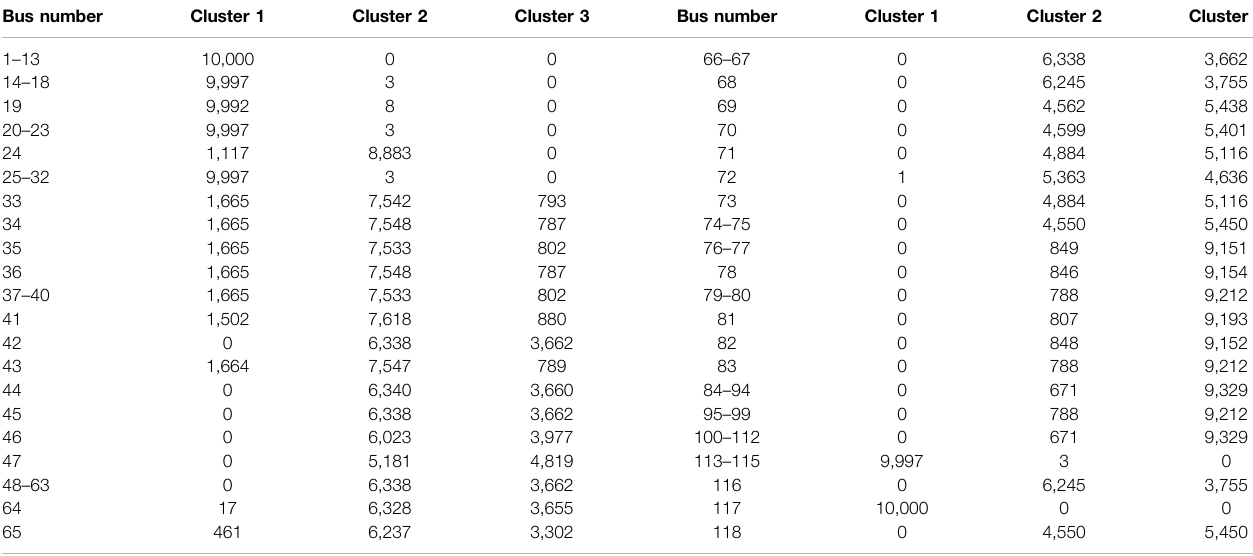
TABLE 4-2 | Simulation results at 50% penetration level.